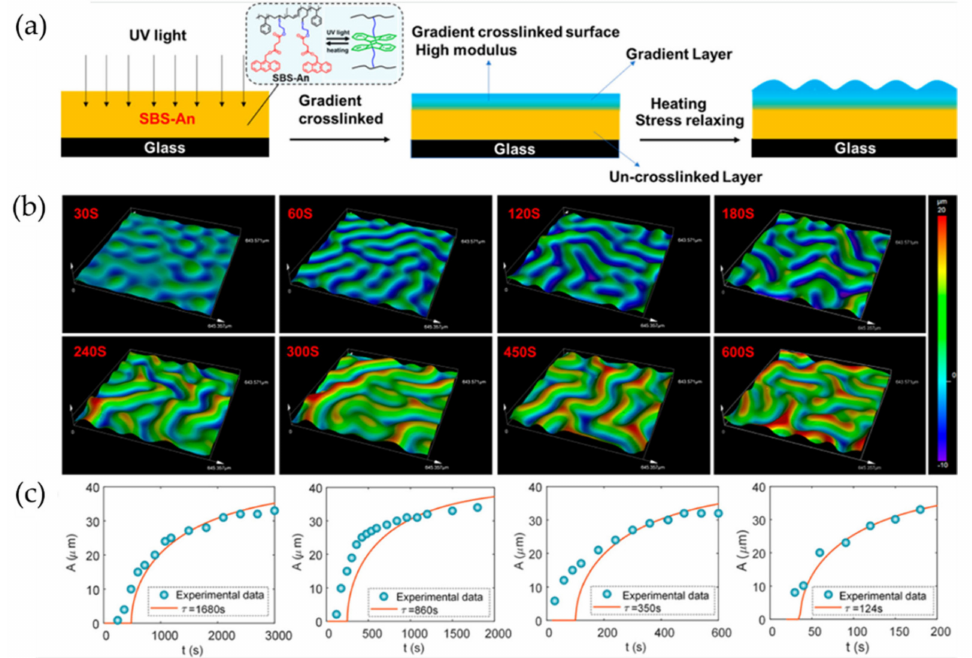
Figure 9. ( a ) Schematic representation of the self-wrinkling process, ( b ) Evolution of wrinkle mor- phology at 120 ◦ C for different times, and ( c ) Morphology evolution at different temperatures (100, 110, 120, and 130 ◦ C). Reproduced with permission from reference [55]. Copyright 2022, American Chemical Society